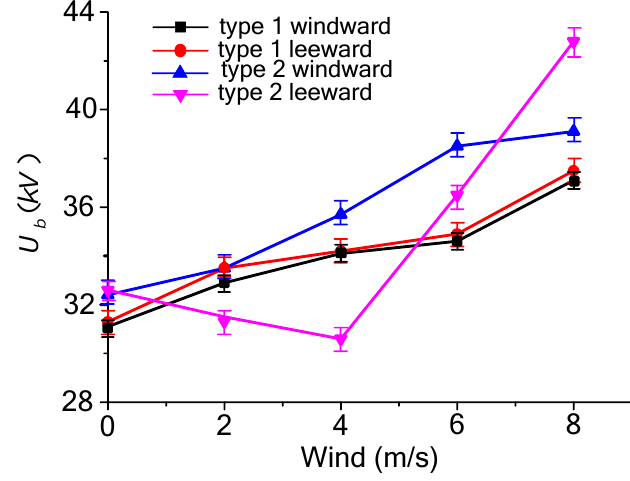
Figure 8. Wind effects on the flashover voltage.